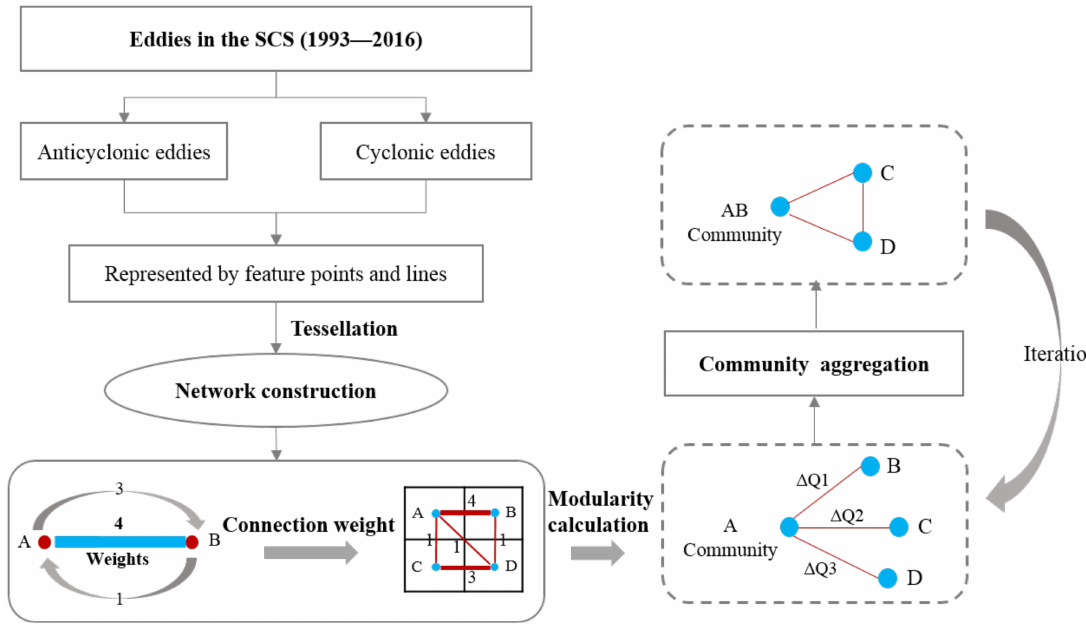
Figure 3. Community partition